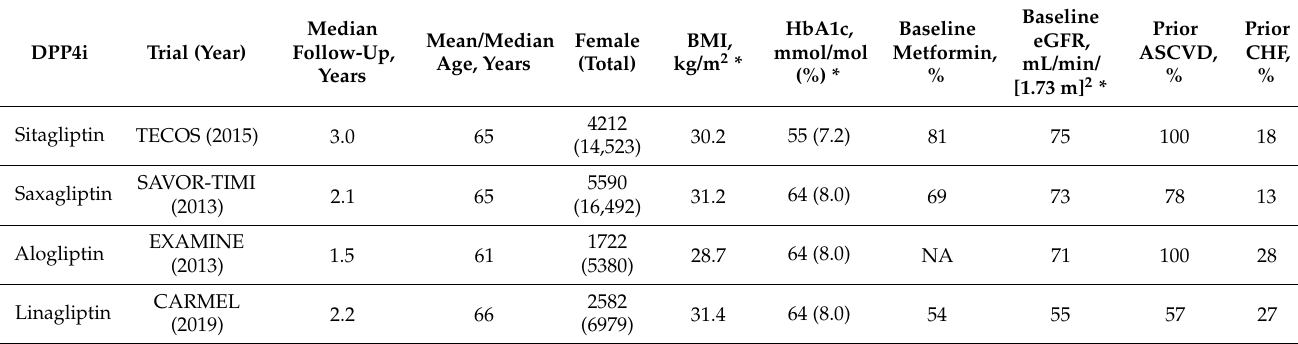
Table 2. Cardiovascular outcome trials with DPP4